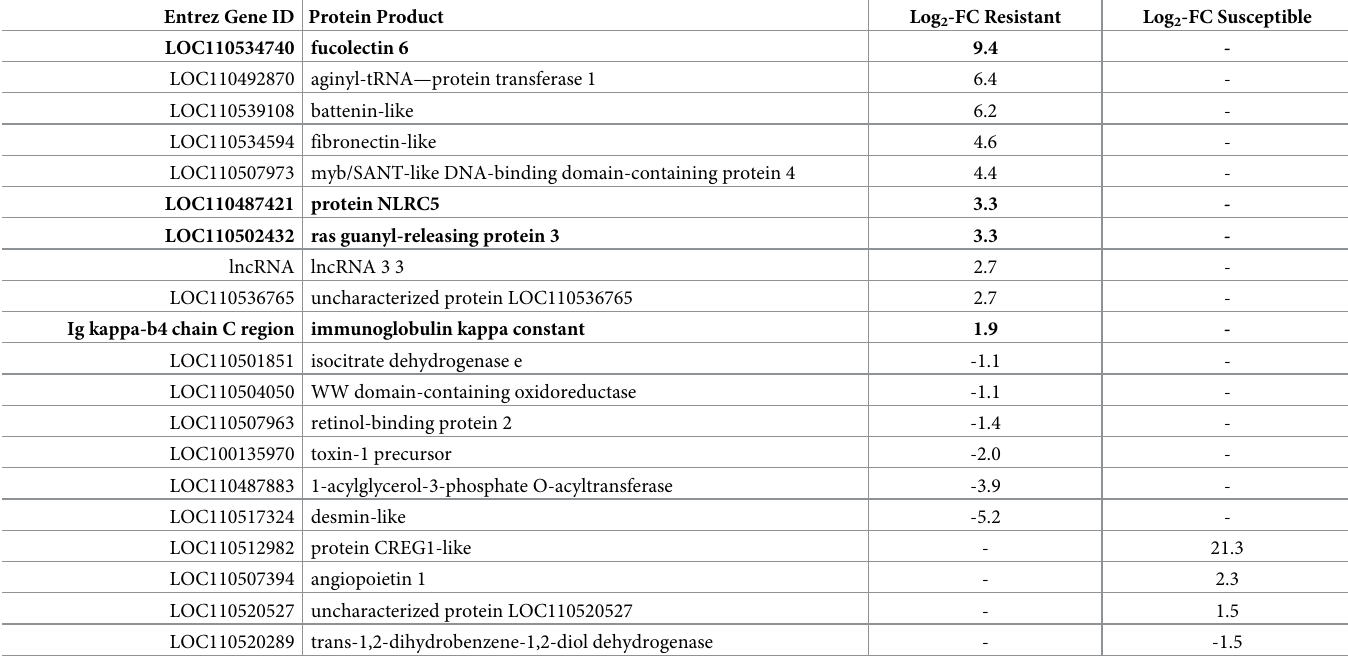
Table 4. Genes that were differentially expressed in the intestine of resistant and susceptible steelhead 7 days post exposure to Ceratonova shasta . Entrez Gene ID Protein